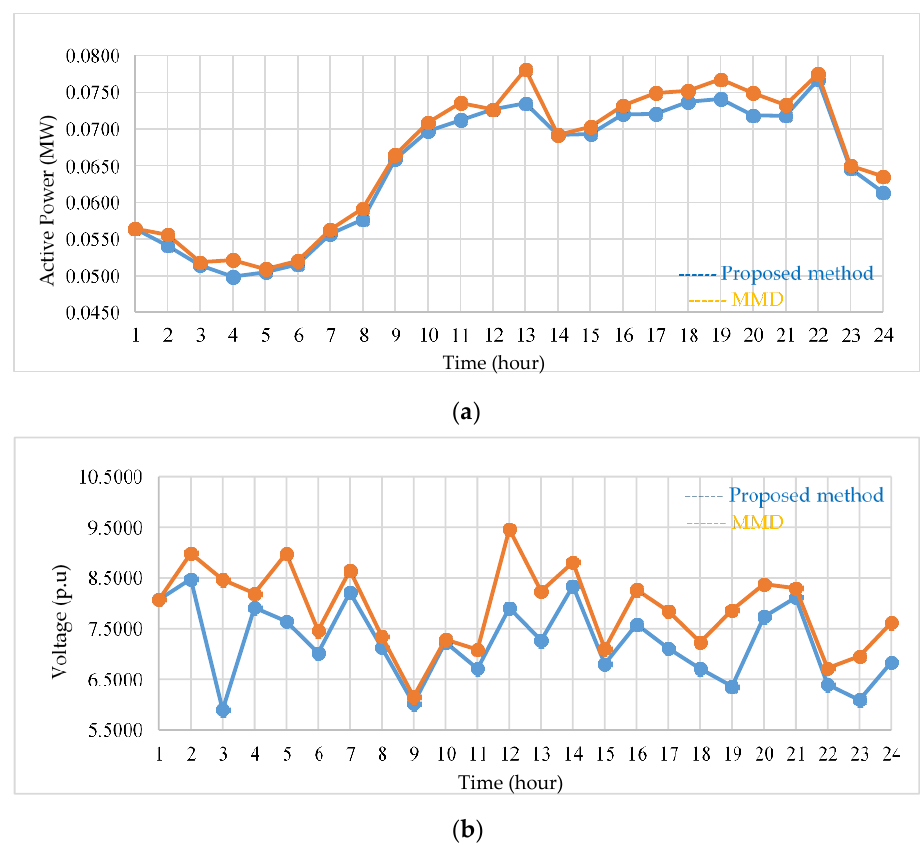
Figure 18. Two BESSs case study: ( a ) generator output; ( b ) RVSI.